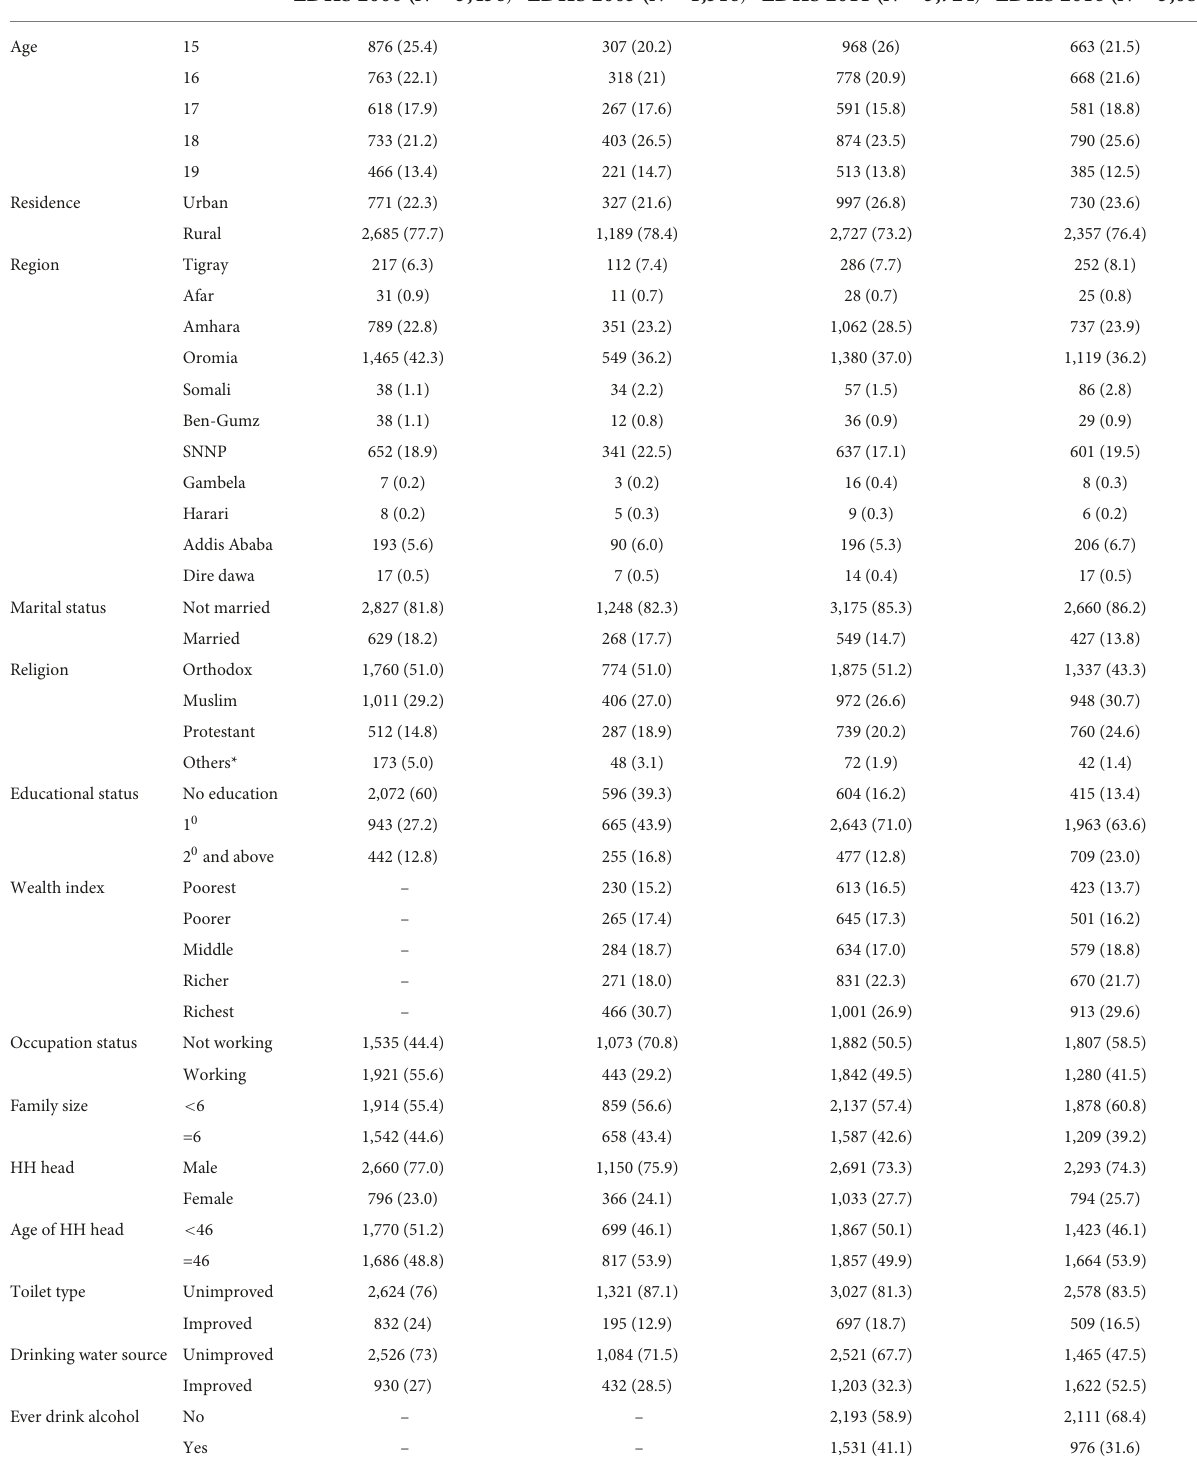
TABLE 1 Percentage distribution of characteristics of adolescent girls in 2000, 2005, 2011, and 2016 Ethiopian demographic and health surveys.